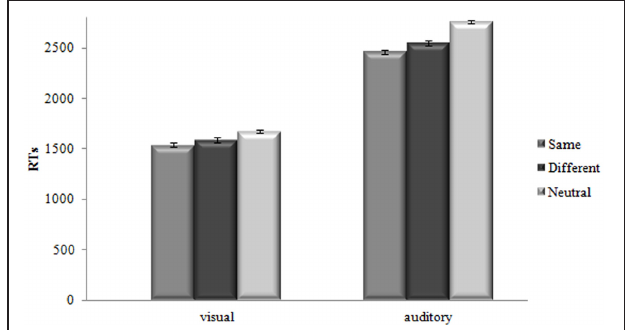
FIGURE 1 | Mean Response Times (RTs) (in Milliseconds) as a Function of Modality (same, different, neutral) for both visual and auditory conditions. Bars are standard